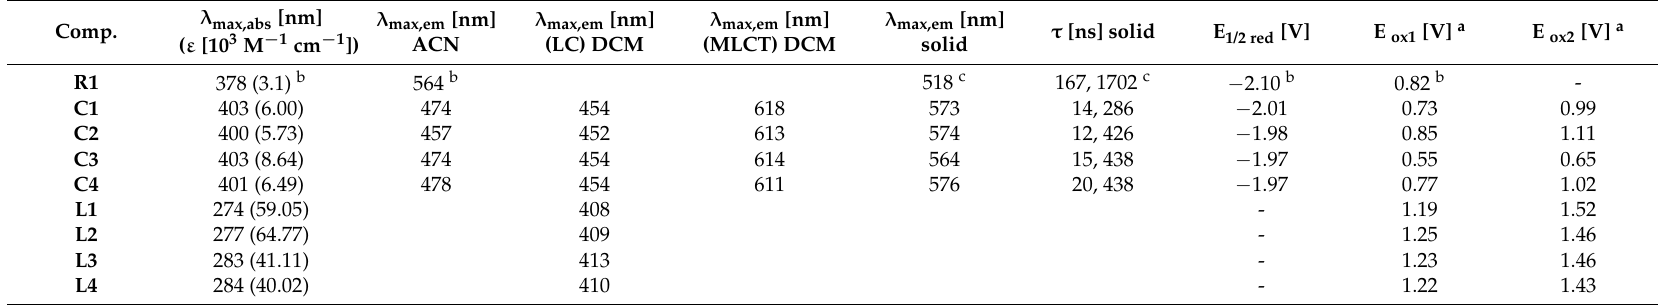
Table 2. Summary of the photophysical and electrochemical properties of the complexes C1 – C4 and their respective ligands L1 – L4 . The UV/vis absorption of the complexes was determined in aerated acetonitrile (ACN), while the ligands were measured in aerated dichloromethane (DCM) due to solubility issues. Emission of the complexes ( λ exc = 400 nm) was detected at room temperature in acetonitrile in the absence of oxygen and of the ligands ( λ exc = 355 nm) in dichloromethane under the same conditions. For the emission lifetime measurements all samples were excited at 355 nm. Redox potentials of the complexes C1 – C4 were measured in deaerated acetonitrile and of the ligands L1 – L4 in deaerated dichloromethane with 0.1 M TBAPF 6 as supporting electrolyte vs. Fc/Fc + .